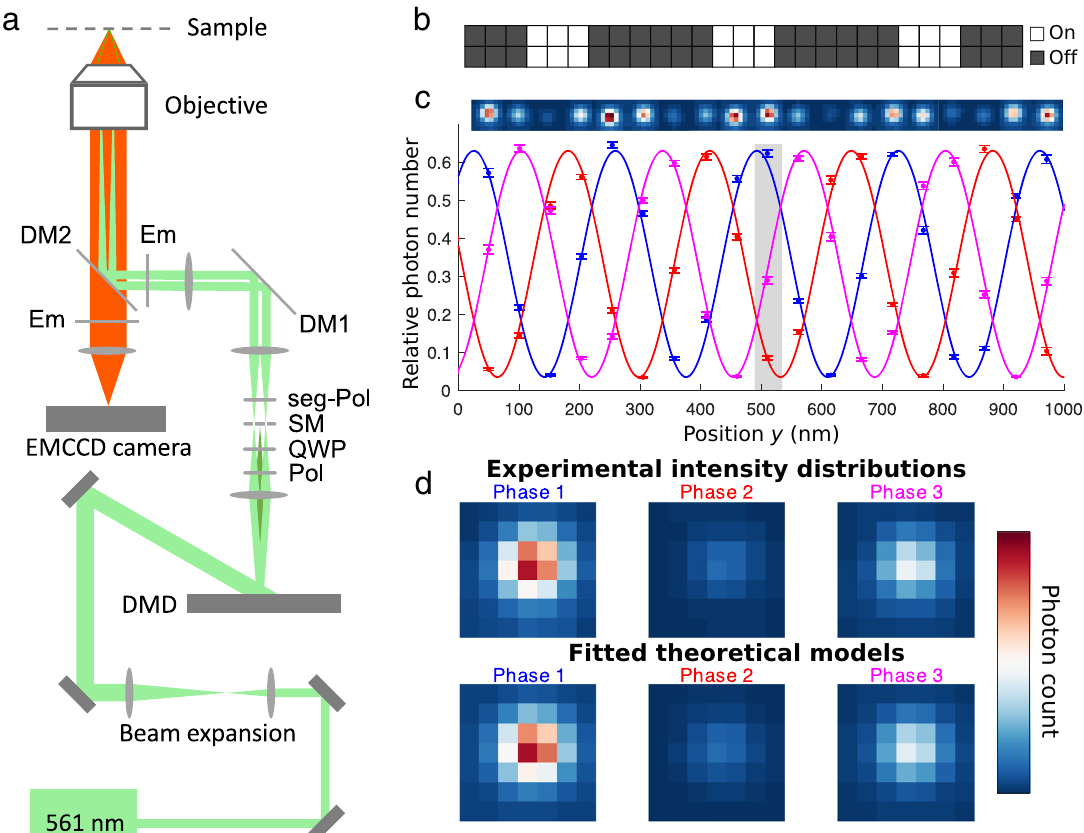
Fig. 2 Implementation of C-MELM using a digital micromirror device (DMD). a Experimental setup consisting of a commercial wide- fi eld epi- fl uorescence microscope with a modi fi ed excitation path (Methods): The excitation light (green) is re fl ected off the DMD before it is relayed by a telescope, undergoes diffraction through the objective and results in structured illumination in the sample plane. See Supplementary Fig. 2 for details. b Subset of the DMD array con fi gured in a periodic series of “ on ” and “ off ” -mirrors. c , d Example characterization of the structured illumination using a single 46-nm fl uorescent bead (Methods). c We translated a fl uorescent bead relatively to the structured illumination generated with the DMD con fi guration in b and recorded the number of photons in its resulting diffraction-limited spots (top row) for each position (blue dots) during 50-ms exposures. For each position of the bead, this was repeated for a total of three phases of the structured illumination (colored dots). A harmonic function with parameters obtained by a fi t to data (colored curves, Methods, Supplementary Note 3) describes the data perfectly and thus characterizes the structured illumination. For each position, the total intensities were normalized by the total photon number observed in the three diffraction-limited spots recorded at that position. Error bars represent standard error of the calculated relative photon number. d Experimental bead images (top row) obtained at a single stage position (gray area in c ) under illumination from three different phases as in c . All three images are fi tted with a point-spread function model (bottom row) for a point-source under assumption that its position is identical in the three images (Methods, Supplementary Note 3). This enables accurate estimation of total intensity also in dim images (e.g., for Phase 2). The effective pixel size was 107